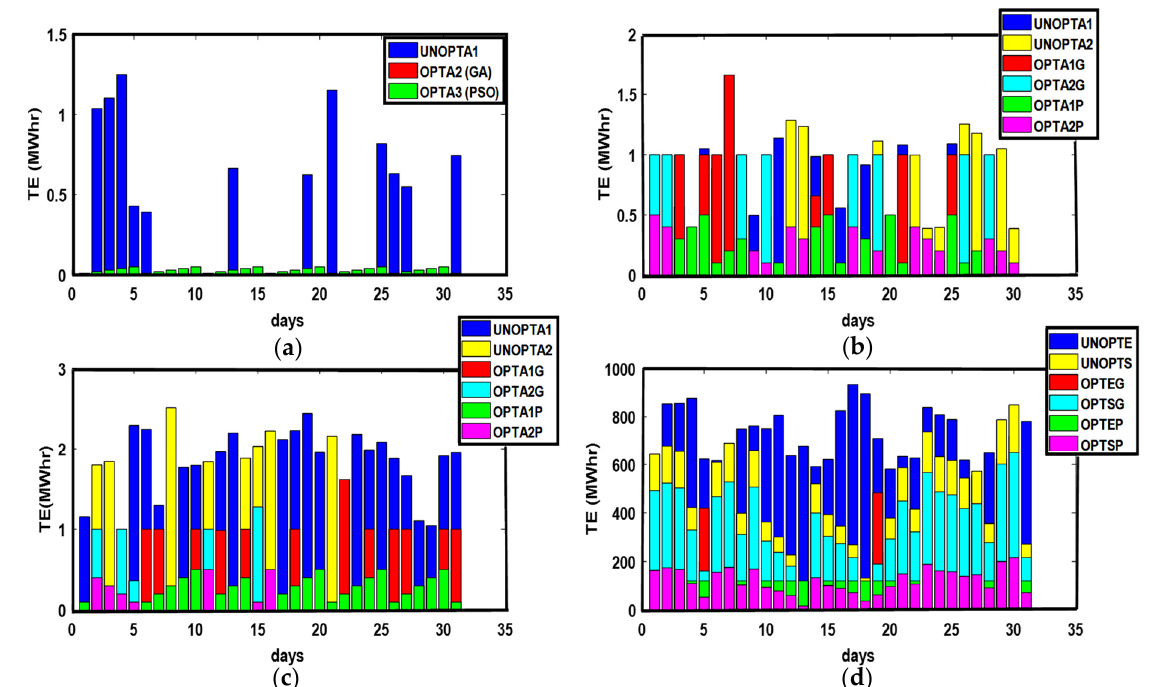
Figure 3. ( a ) P-C, ( b ) P-P, ( c ) ED-ED, and ( d ) ED-SG Energy Transactions. ( a ) TE: Transacted Energy, UNOPTA1: Unopti-